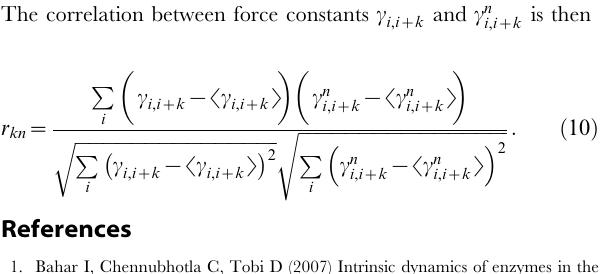
Figure S1 Distribution of the force constants corresponding to non-bonded interactions of twenty different types of amino acids. Axes are identical in all plots. Mean values and standard deviations are listed in each case. Figure S2 Scatter plots of k = 2 force constants against k = 1 force constants for helices (red circles) and strands (blue squares). Figure S3 Relationship between mean square fluctuations and inverse node weight. In GNM (red circles) the weight of a node is the number of its edges, ni. In OFC-GNM (blue squares), the edge weight is the sum of the magnitudes of all its edges. The correlations with the linear fits shown are 0.416 and 0.670, respectively. Table S1 Training set proteins DOC) Table S2 Test set proteins DOC) Table S3 Test set mGNM results by